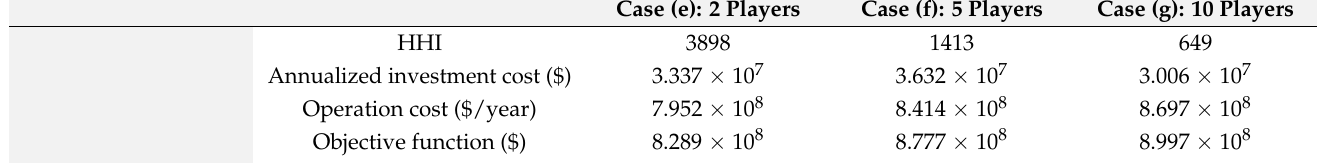
Table 3. Optimal solutions considering different numbers of market players.